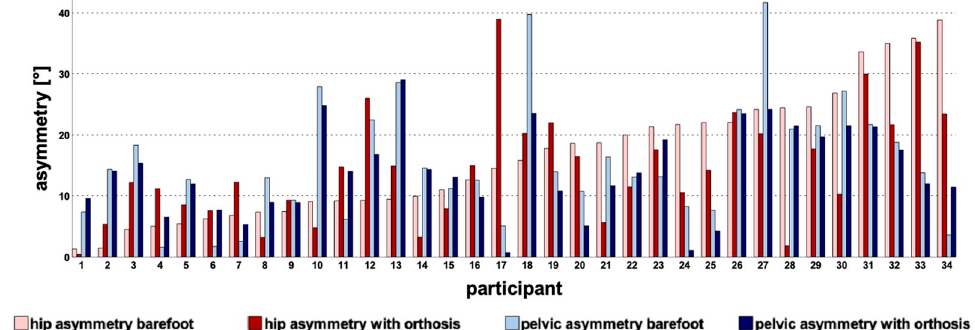
Figure 4. Illustration of hip (red) and pelvic (blue) asymmetry barefoot (light colored) and with orthosis (dark colored). X-axis: 34 patients (4 bars per participant), in order of ascending hip asymmetry barefoot. Y-axis: absolute value of difference in affected and unaffected sides.